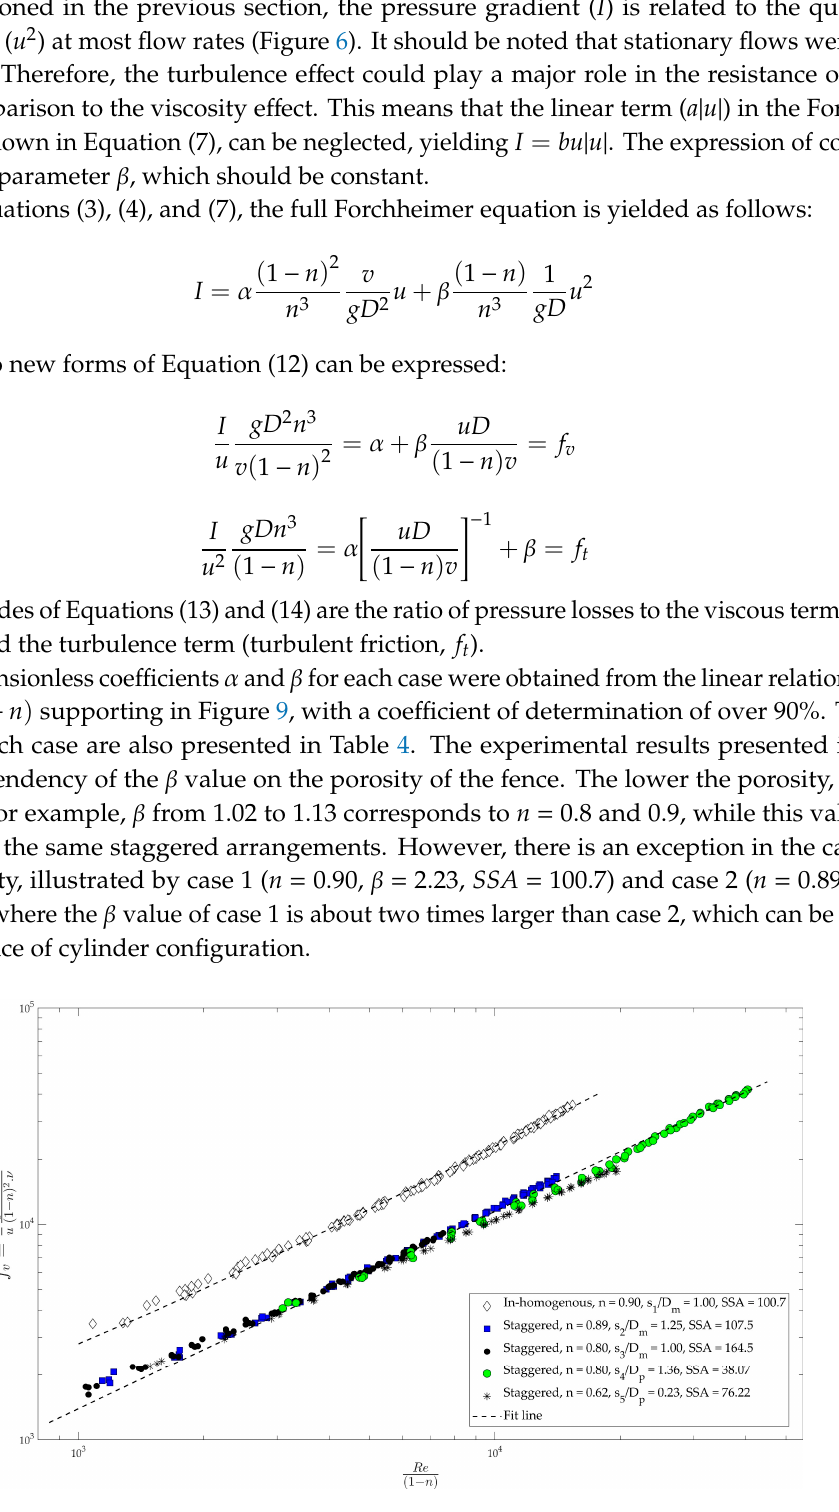
Figure 9. Relationship between f v and Re / ( 1 − n ) Table 3. 𝑪 𝑫 (cid:3364)(cid:3364)(cid:3364)(cid:3364) and 𝑹𝒆 𝒏 relation formulas Formula